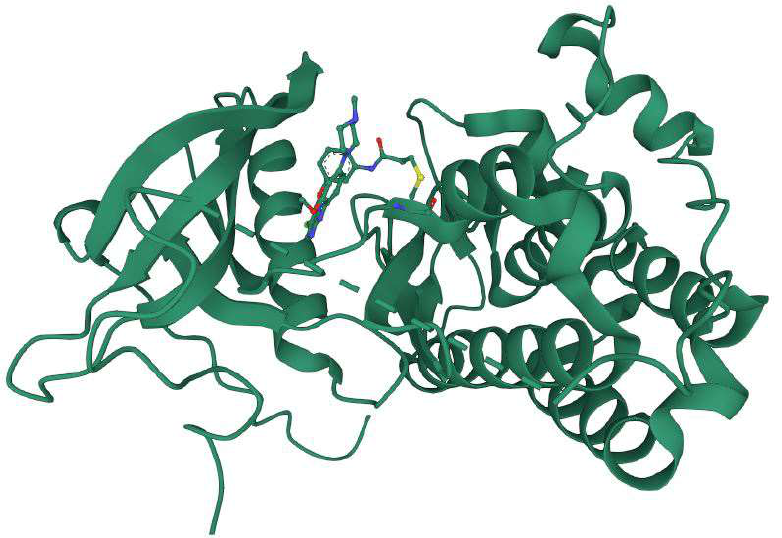
Figure 4. Co-crystallized structure of EGFR T790M with a pyrimidine derivative WZ4002 (PDB ID: 3IKA) (Image courtesy of RSCB PDB: https://www.rcsb.org, accessed on 31 December 2022)